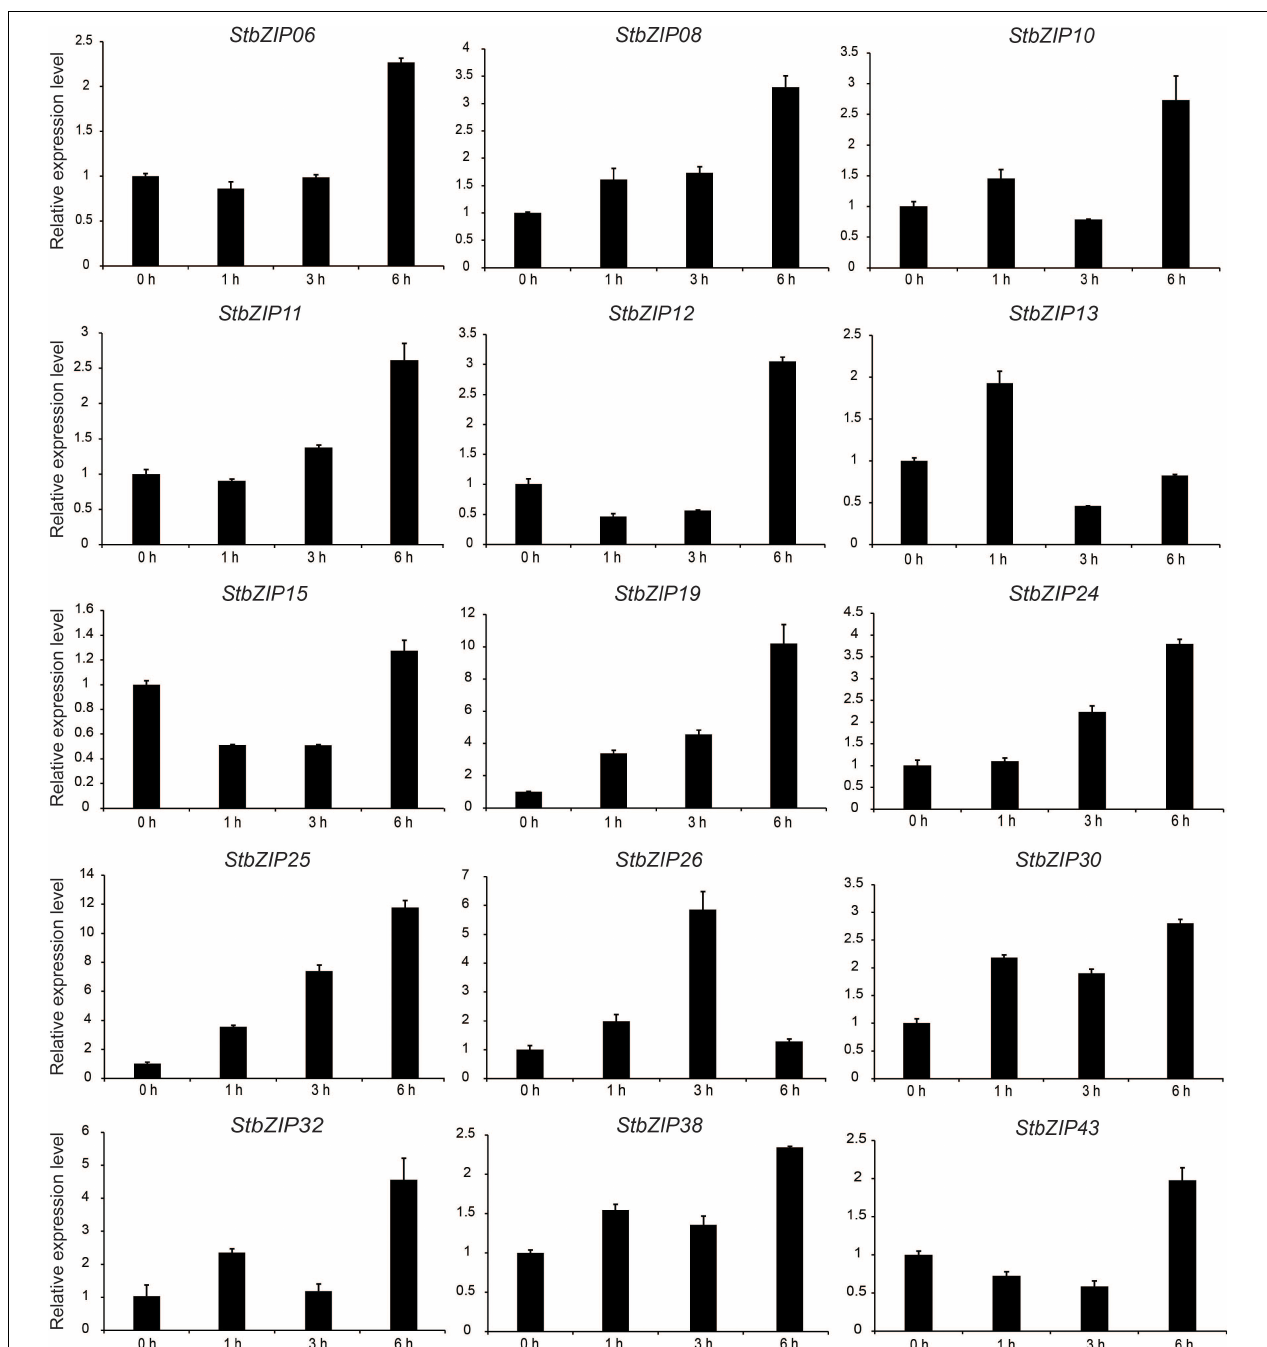
FIGURE 8 | The expression patterns of selected StbZIP genes in response to salt stress treatments, which were calculated as folds relative to the untreated control.